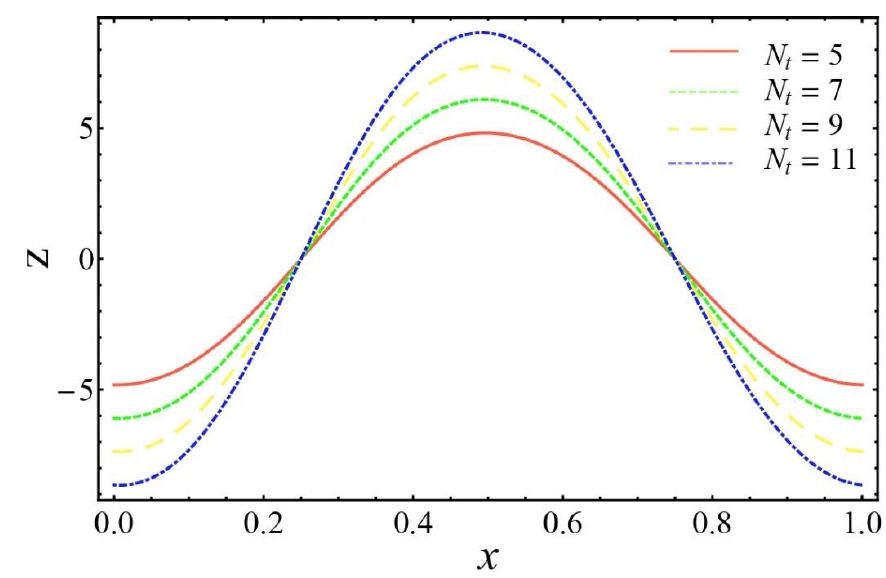
Figure 14. Alteration of 𝑁 𝑡 on 𝑧 when 𝑡 = 0; 𝑄 = 10; 𝛽 = 0.2; 𝜖 = 0.2; 𝑁 𝑏 = 5; 𝑁 𝑑 = 2; 𝑘 = 2. Figure 14. Alteration of N t on z when t = 0; Q = 10; β = 0.2; (cid:15) = 0.2; N b = 5; N d = 2; k =